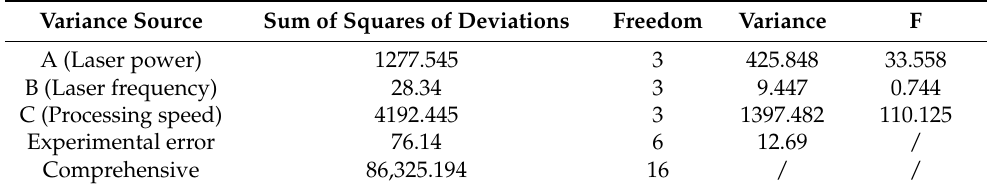
Table 12. Variance analysis of processing time.